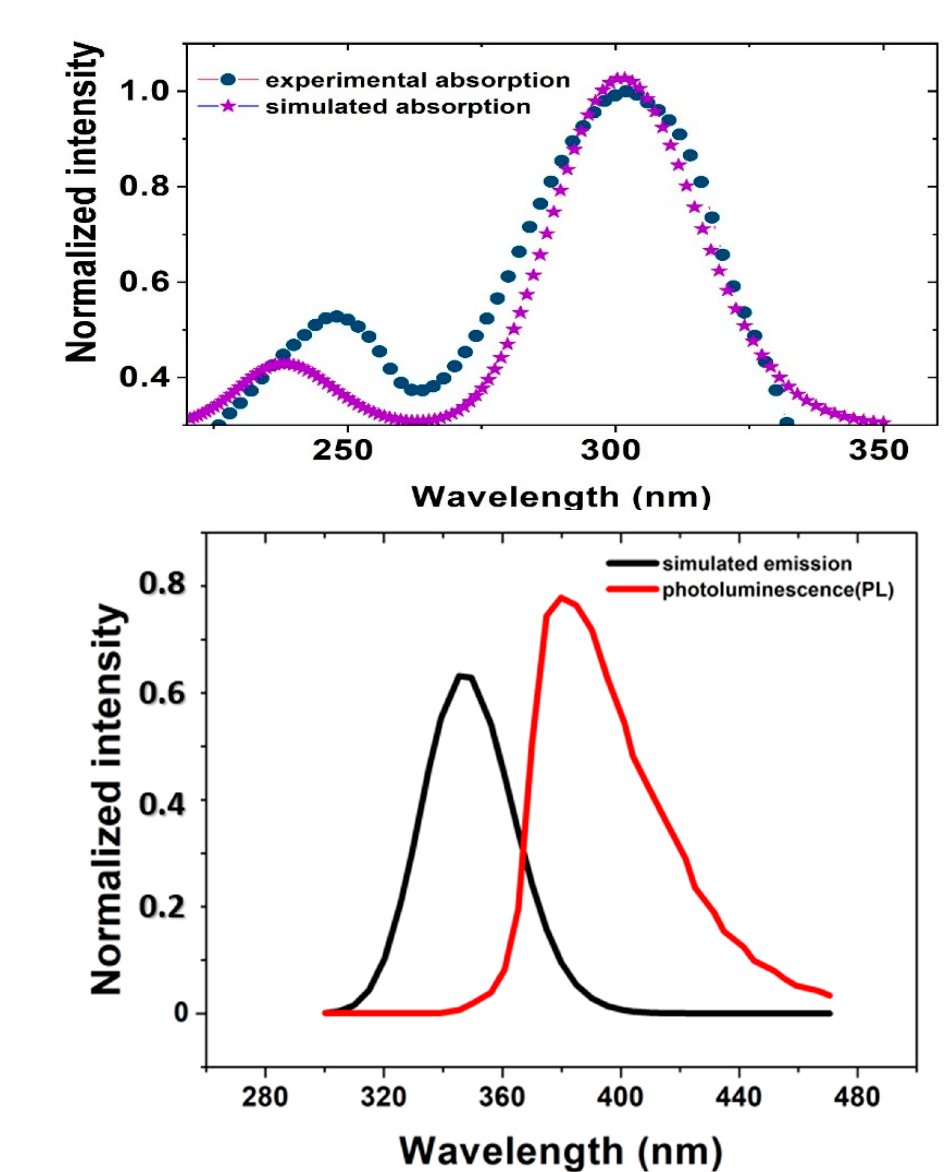
Figure 5. ( a ) Cyclic voltammetry results for T2. Oxidation potential (E ox ) and reduction potential (E red ) can be obtained from the cyclic voltammetry curve; ( b ) Comparison of UV/Vis spectra of T2 from molecular simulations and experimental measurements; ( c ) Comparison of PL measurements and quantum simulation calculations for T2 emission spectrum.